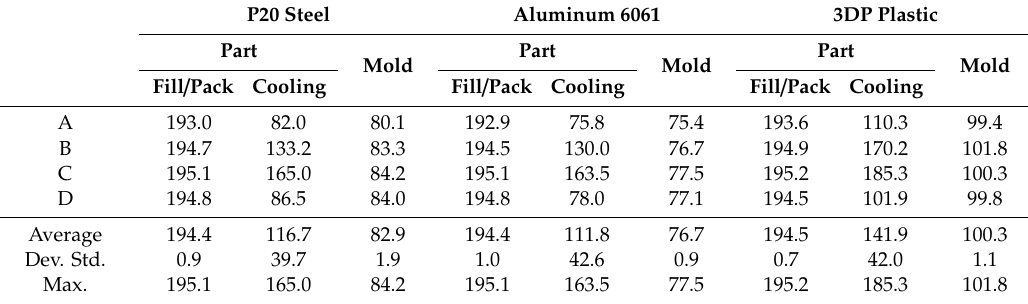
Table 9. Maximum temperature values for the part and the mold monitored for the different mold materials.